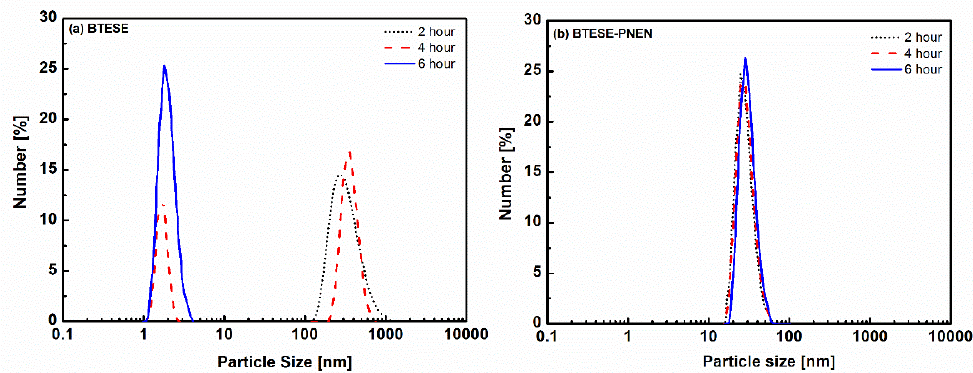
Figure 2. Particle sizes of ( a ) BTESE sols and ( b ) BTESE-PNEN sols (after reacting for 2 h) at different reaction times.